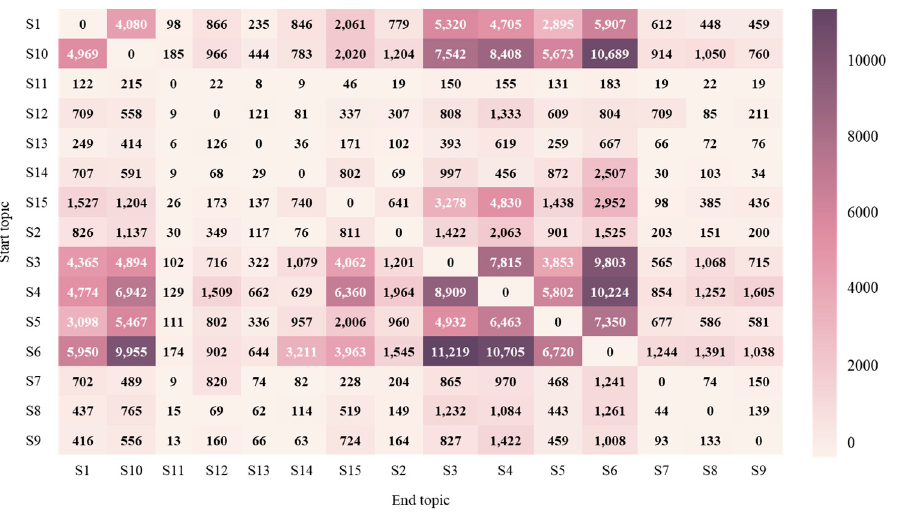
Figure 11. The spatial distribution of COVID-19-related semantic change events. Sub-figures a-f show the kernel density of semantic change events in: ( a ) China; ( b ) Beijing–Tianjin–Hebei region; ( c ) Yangtze River Delta region; ( d ) Hubei Province; ( e ) Guangdong Province; ( f ) Sichuan Province.